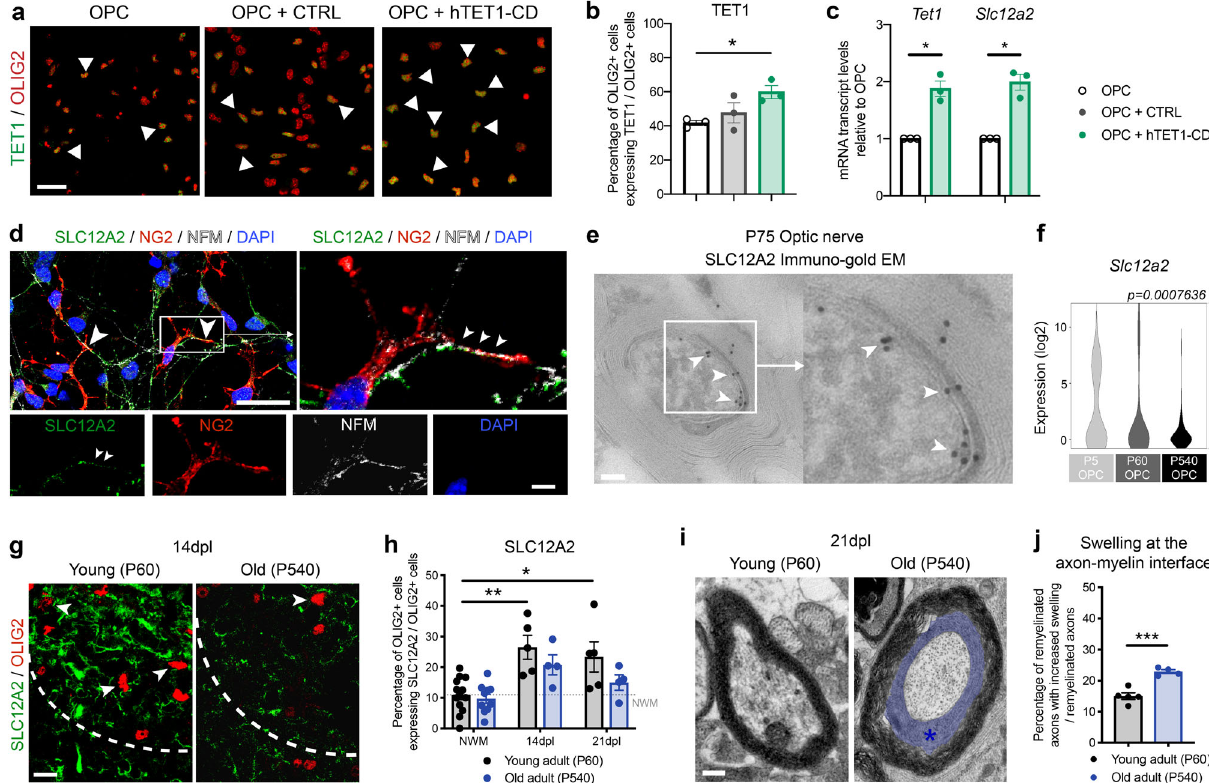
Fig. 7 The protein encoded by the TET1-target gene Slc12a2 is localized at the axon – myelin interface. a Representative images of cultured OPCs, transduced with the indicated lentiviral vectors and then stained for TET1 (green) and OLIG2 (red). White arrowheads indicate co-labeled cells. Scale bar = 25 µ m. b Quanti fi cation of the percentage of OLIG2 + cells expressing TET1 in untransduced OPC and in cells transduced either with CTRL or hTET1-CD lentiviral vectors. Error bars represent SEM in n = 3 independent experiments (* p < 0.05, one-way ANOVA). c Quantitative real-time PCR analysis of Tet1 and Slc12a2 transcript levels in immunopanned OPCs after transfection with hTET1-CD lentivirus. Data represent average transcript levels relative to untransfected OPCs in n = 3 independent experiments. Error bars represent SEM (* p = 0.0232 for Tet1 , * p = 0.0192 for Slc12a2 , Student ’ s t test two-tailed). d Confocal image of mixed neuronal/glial cortical cultures. SLC12A2 (in green) is expressed by differentiating oligodendrocyte progenitors (co- stained with NG2, in red), and localized at contact points with axons (stained with NFM, in white). DAPI (blue) used as nuclear counterstain. White arrowheads indicate NFM + and NG2 + neuron-glial contact points co-labeled with SLC12A2. Scale bars = 50 µ m and scale bars = 10 µ m for high magni fi cation images. e Immunogold staining for SLC12A2 on EM imaging in adult P75 WT optic nerves, showing the localization of SLC12A2 at the axon – myelin interface (white arrow-heads). Scale bar = 5 µ m and scale bar = 1 µ m for high magni fi cation images. f Violin plots of Slc12a2 transcript levels in nOPC at P5 ( n = 61 single cells), aOPC at P60 ( n = 76 single cells), and oOPC at P540 ( n = 51 single cells). Note the age-dependent decline of Slc12a2 transcripts (one-way ANOVA, for age). g Representative confocal image of young and old spinal cord sections, stained 14 days after lesion for SLC12A2 (green) and OLIG2 (red). The dotted white line indicates the lesion border. White arrowheads indicate co-labeled cells. Scale bar = 50 μ m. h Quanti fi cation of in the percentage of OLIG2 + cells expressing also SLC12A2 in young and old lesioned spinal cords at 14dpl and 21dpl. Dotted gray line across indicates the percentage of OLIG2 + cells expressing SLC12A2 in unlesioned white matter tracts (NWM). Data represent average values quanti fi ed in 4 sections/ mouse for n = 5 young and n = 4 old mice (* p < 0.05 and ** p < 0.01, two-way ANOVA, for age and time after lesion). i Representative electron micrographs of young and old spinal cord sections at 21dpl, revealing increased swelling at the axo-myelinic interface (blue area and * asterisk). Scale bar = 10 µ m. j Quanti fi cation of the percentage of remyelinated axons with swelling at the neuro-glial interface in young and old spinal cord lesions at 14dpl. Data represent the average values. Error bars represent SEM for n = 5 young and n = 4 old mice (*** p = 0.0005, Student ’ s t test